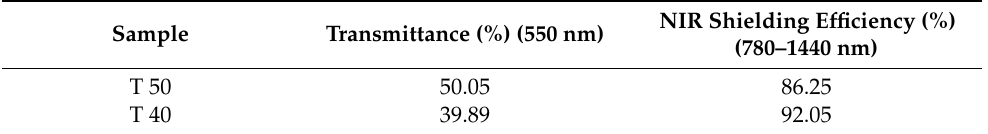
Figure 6. Transmittance spectra of PEDOT:P(SS-co-St) films with transmittance of 40% and 50% at 550 nm. For comparison, the standard solar irradiation spectrum and the transmittance spectrum of the pristine PET film are provided. Table 2. Transmittance in the visible region and shielding efficiency in the NIR region of selected PEDOT:P(SS-co-St) films.